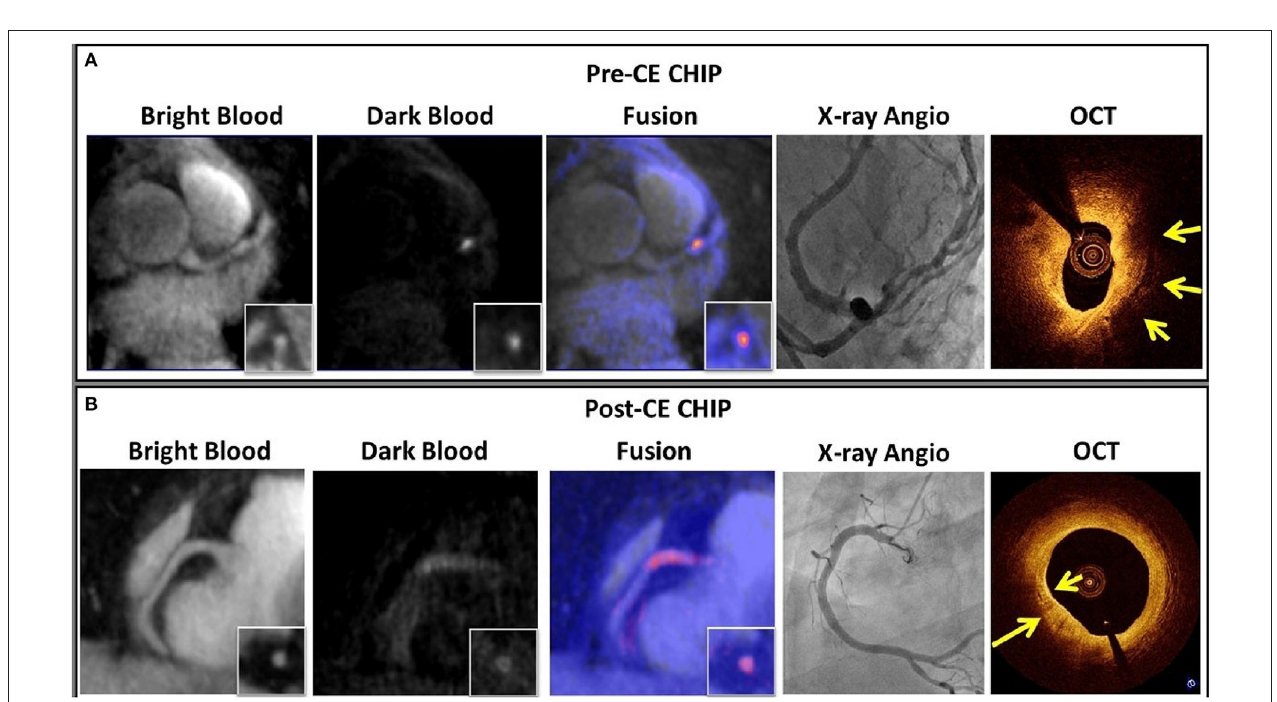
FIGURE 13 | (A) An example of pre-CE CHIP was found in the middle LAD visualised on the dark blood images and fused with the bright-blood scan. XA showed significant stenosis (70%) at that location. OCT showed large signal-poor area suggestive of possible lipid core and/or intra-plaque haemorrhage (yellow arrow). (B) An example of post-CE CHIP with diffuse wall enhancement at proximal RCA as localized on the bright-blood images. XA showed only mild stenosis (30%) at that location. OCT showed strong multi-focal back reflections and signal heterogeneity within the overlaying tissue suggestive of high macrophage density (yellow arrows). CE, contrast enhancement; CHIP, coronary hyper-intensive plaques; XA, X-ray angiography; OCT, optical coherence tomography. Adapted with permission from Xie et al. (96).